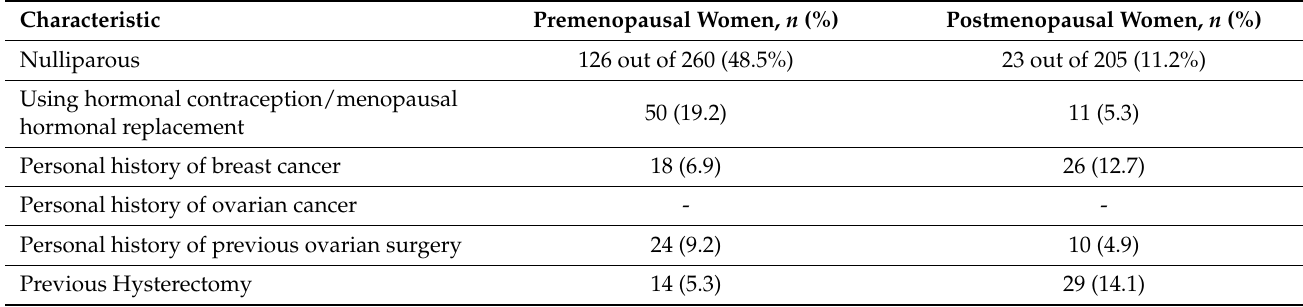
Table 1. Patient demographic and clinical characteristics.